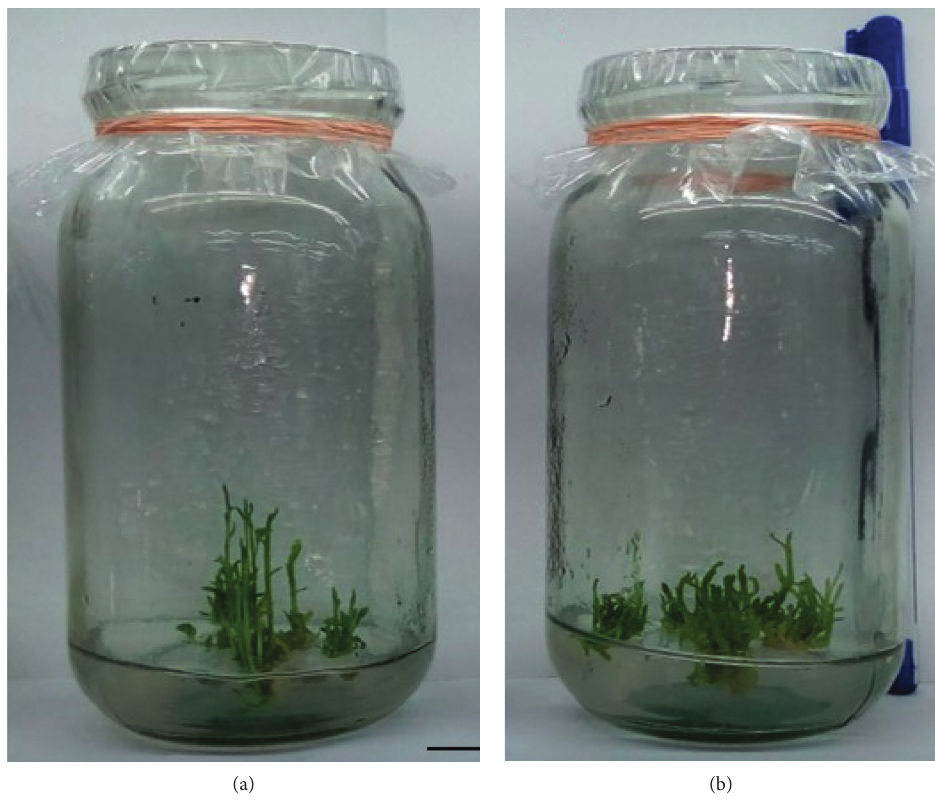
Figure 2: The comparison of shoot growth. (a) Full MS and (b) ½MS media. Scale bar, one cm.